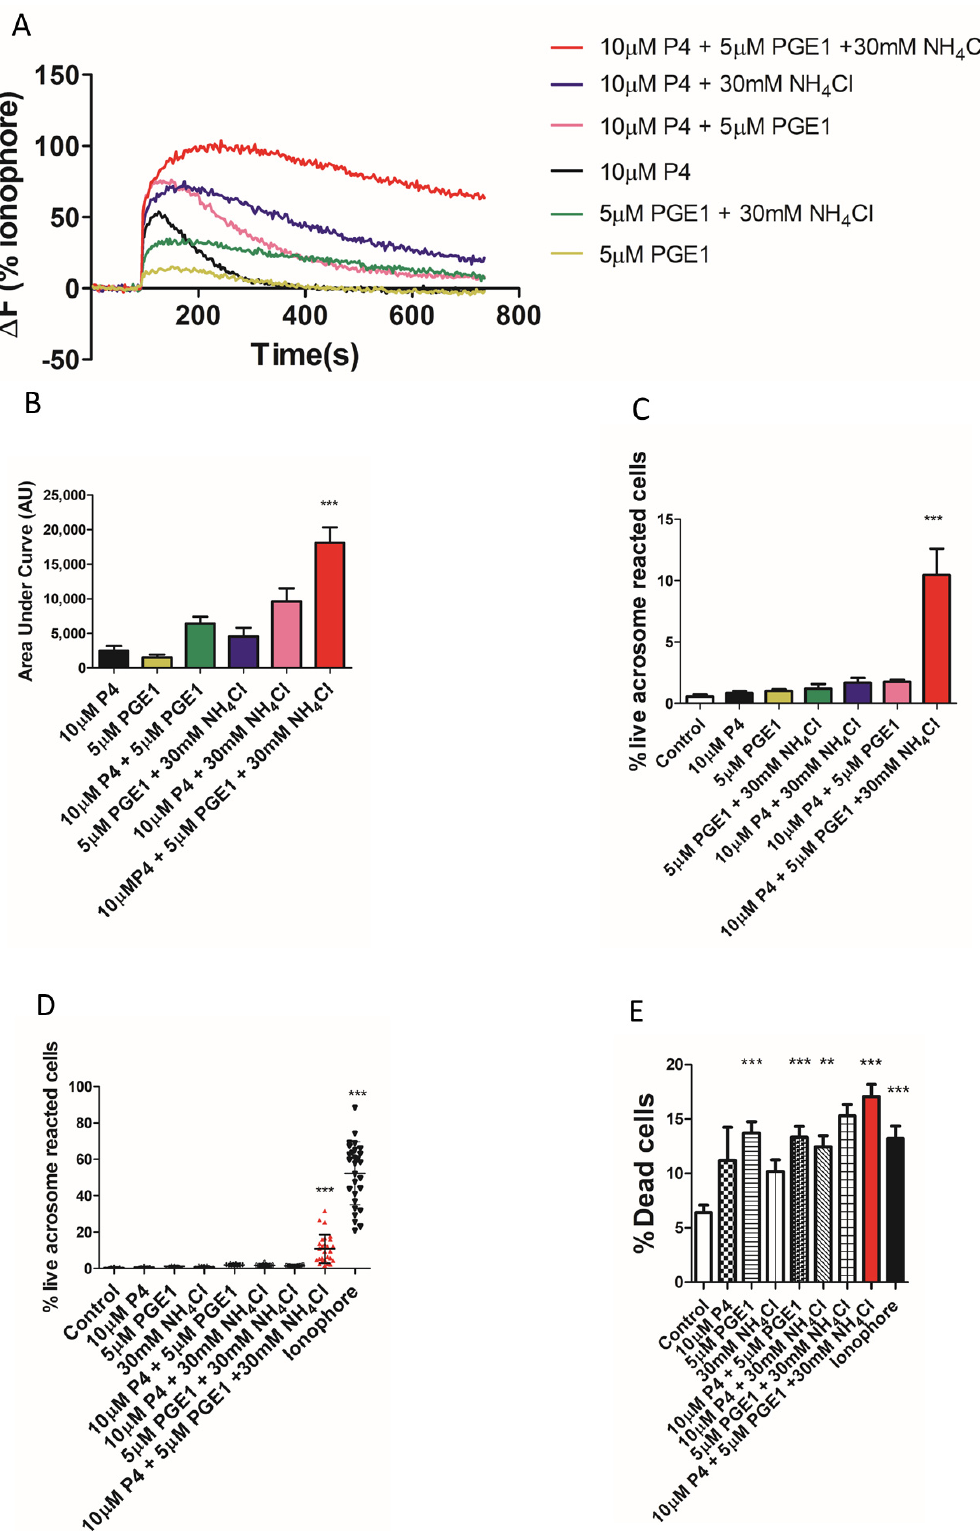
Figure 3. Co-application of progesterone (P4), prostaglandin E1 (PGE1) and NH 4 Cl significantly increases total intracellular calcium and acrosome reaction. ( A ). [Ca 2+ ]i responses to 10 μ M P4, 5 μ M PGE1 alone and in combination with 30 mM NH 4 Cl. ( B ). Quantification of mean area under the curves in ( A ). The total [Ca 2+ ]i response to P4/PGE1/NH 4 Cl is significantly greater than the response elicited by other combinations. AU = arbitrary units ( C ). Only P4/PGE1/NH 4 Cl significantly increases the acrosome reaction. Data for figures ( A–C ) are paired data using five samples from four donors. ( D ). The percentage of live cells that have completed the acrosome reaction in response to P4/PGE1/NH 4 Cl showed high inter-donor heterogeneity but was significantly different to all other conditions ( n = 27 from 18 donors). ( E ). The percentage of dead cells under each experimental condition in ( D ). Data in figure ( D , E ) are paired and presented mean ± SD and are analysed using the Kruskal – Wallis test followed by Dunn’s post-test. Addition of vehicle (DMSO) served as a negative control. ** and *** represents statistical significance of p < 0.01 and <0.001 respectively.